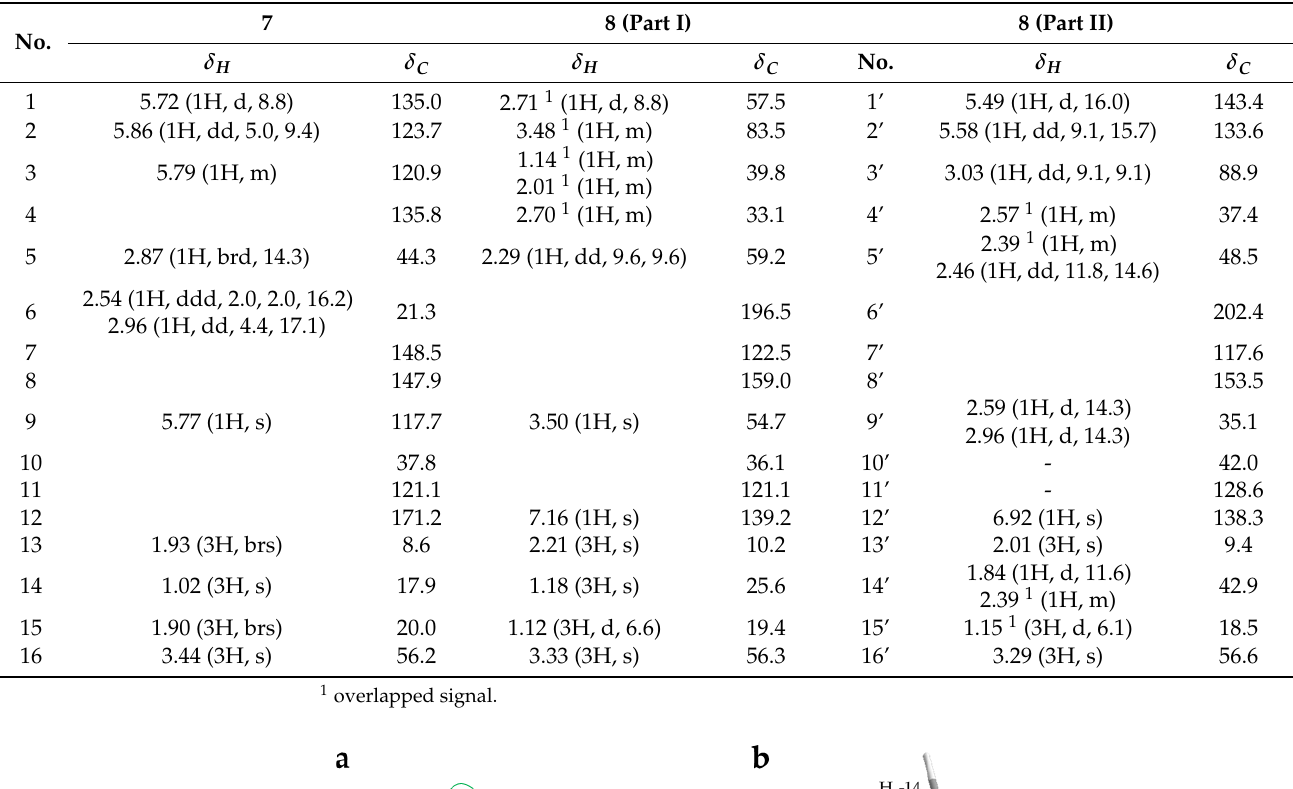
Table 3. 1 H and 13 C NMR data for compounds 7 and 8 (600 and 150 MHz, respectively) in CDCl 3